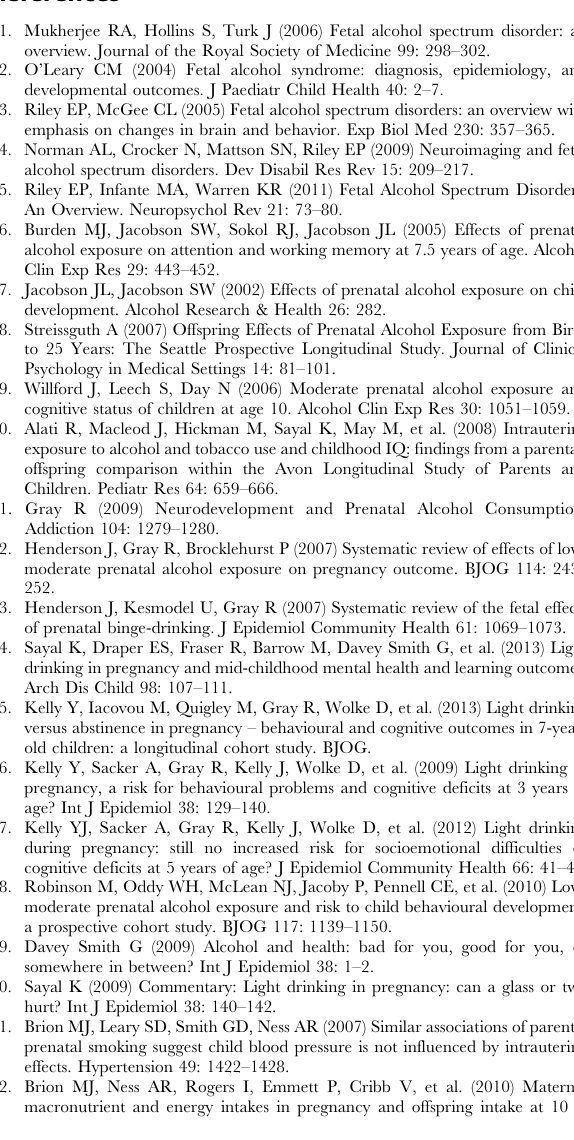
Table S1 Associations between maternal and paternal alcohol consumption in the 1st 3 months of pregnancy and potential confounding factors (complete case anal- ysis (n =7062). Table S2 Associations between maternal and paternal ‘binge’ patterns of drinking in the 1st 3 months of pregnancy and potential confounding factors (complete case analysis (n